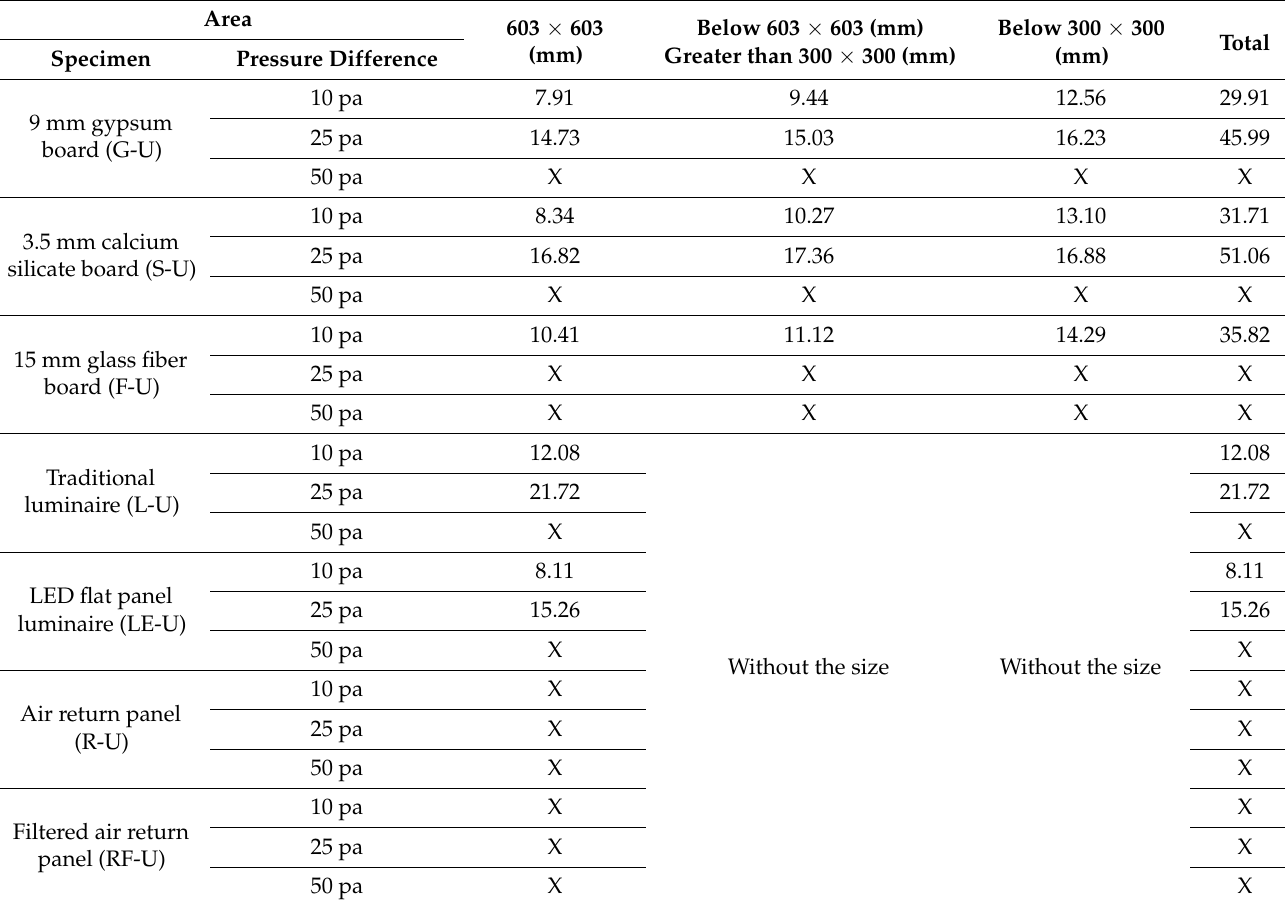
Table 3. Leakage volume per unit for various test specimen sizes with airflow from bottom to top (U) (m 3 /(h.m.)).